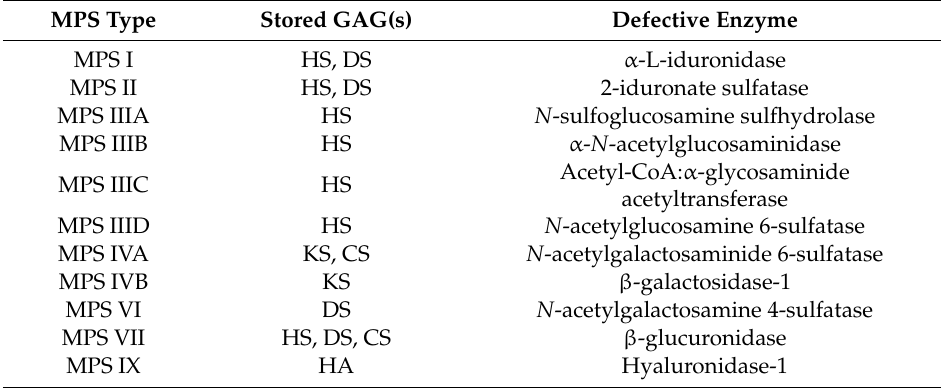
Table 1. Types / subtypes of MPS (based on